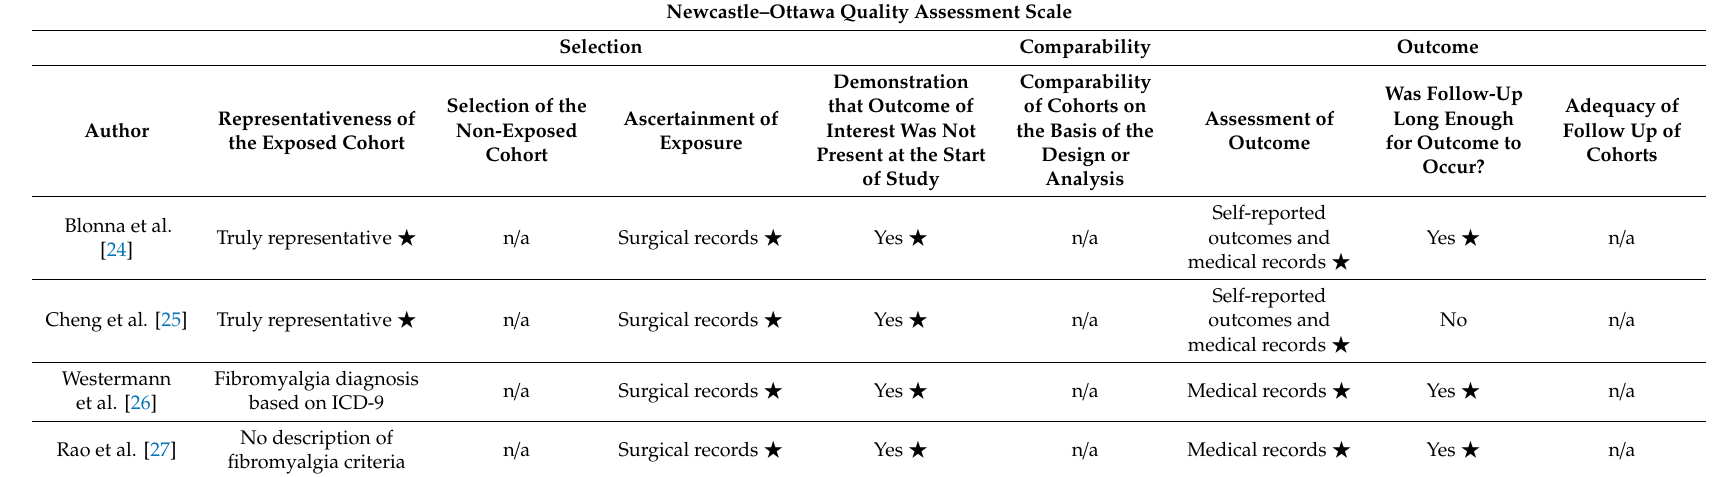
Table 3. Newcastle–Ottawa assessment scale scores for the included